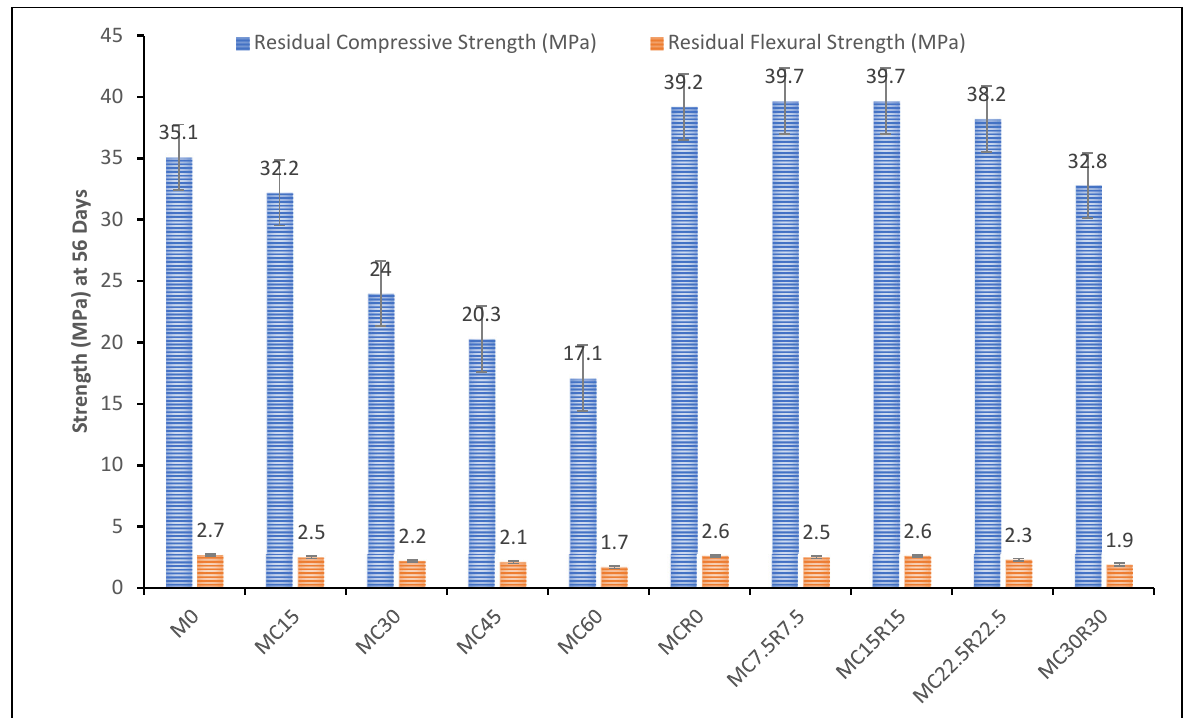
Figure 10. Residual compressive and flexural strength for all mixes after immersion in 10% H 2 SO 4 solution at 56 days.